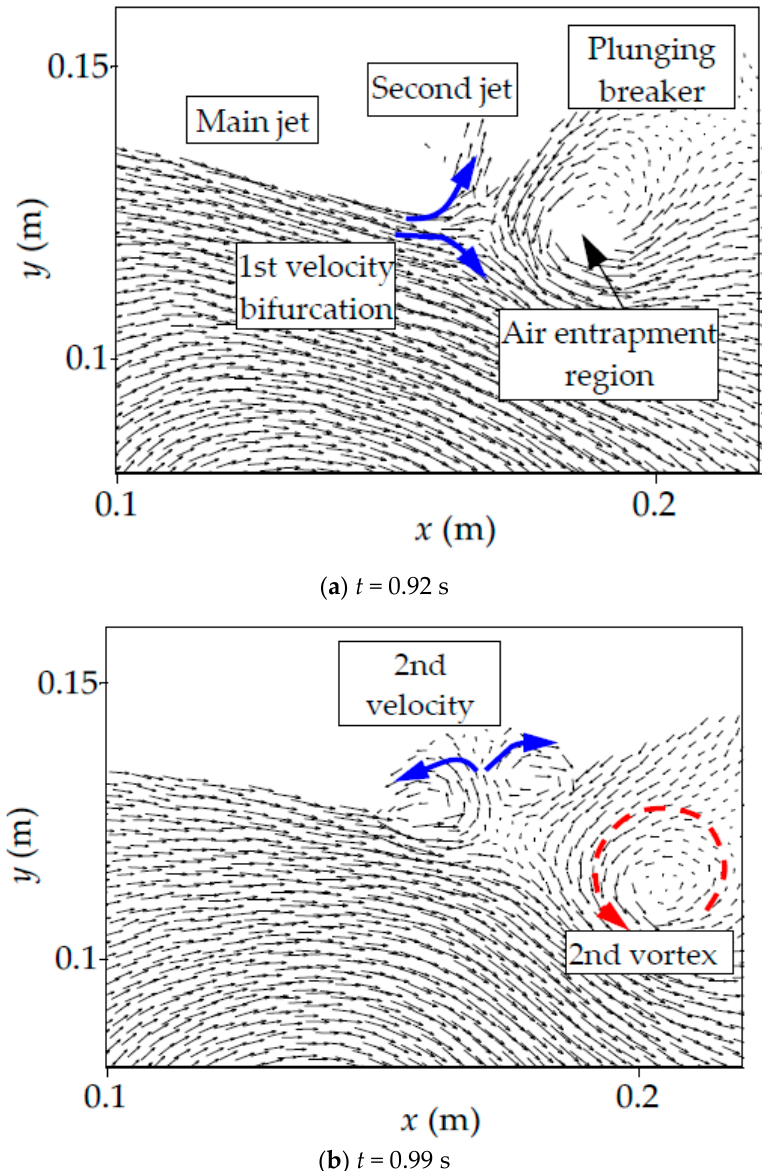
Figure 5. The interaction between the backward plunging breaker and the main jet flow: ( a ) t = 0.92 s; ( b ) t = 0.99 s.